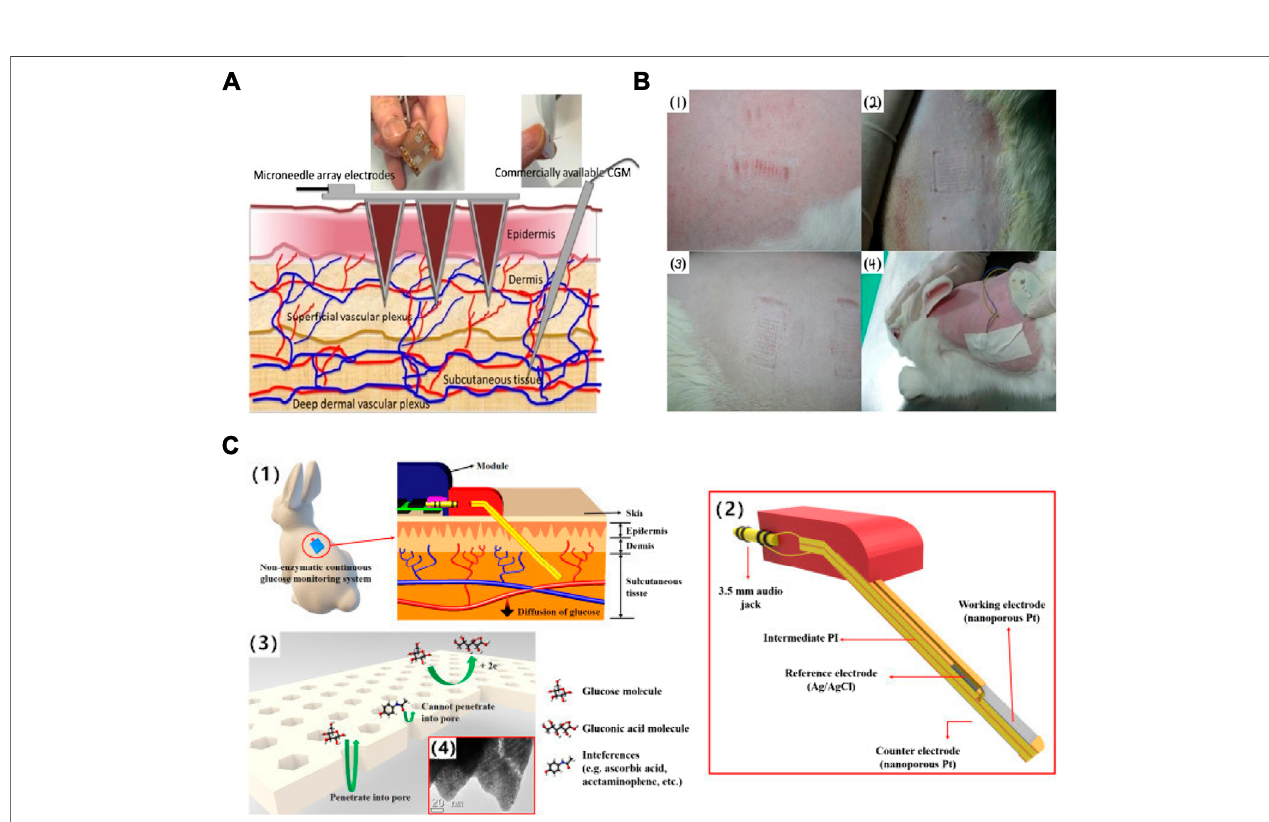
FIGURE2| Theschematicandpro fi lemapoftheinterstitial fl uid-basedCGMs. (A) Twomethods(Microneedlearrayelectrode&&commerciallyCGM)detectedthe concentration of the blood glucose from the interstitial fl uid (Sharma et al., 2016). (B) The photographs of insertion test of the sensor on (1) guinea pig, (2) rat, and (3) rabbit, and (4) the senor after being attached and partially inserted into a rabbit (Lee et al., 2016). (C) Semi-implantable device (1) a rodent worn the semi-implantable CGM. (2) the cross-section view of the device. (3), (4) Progress of oxidation reaction on nPt surface (glucose and interferences) and TEM graph (Yoon et al., 2018).